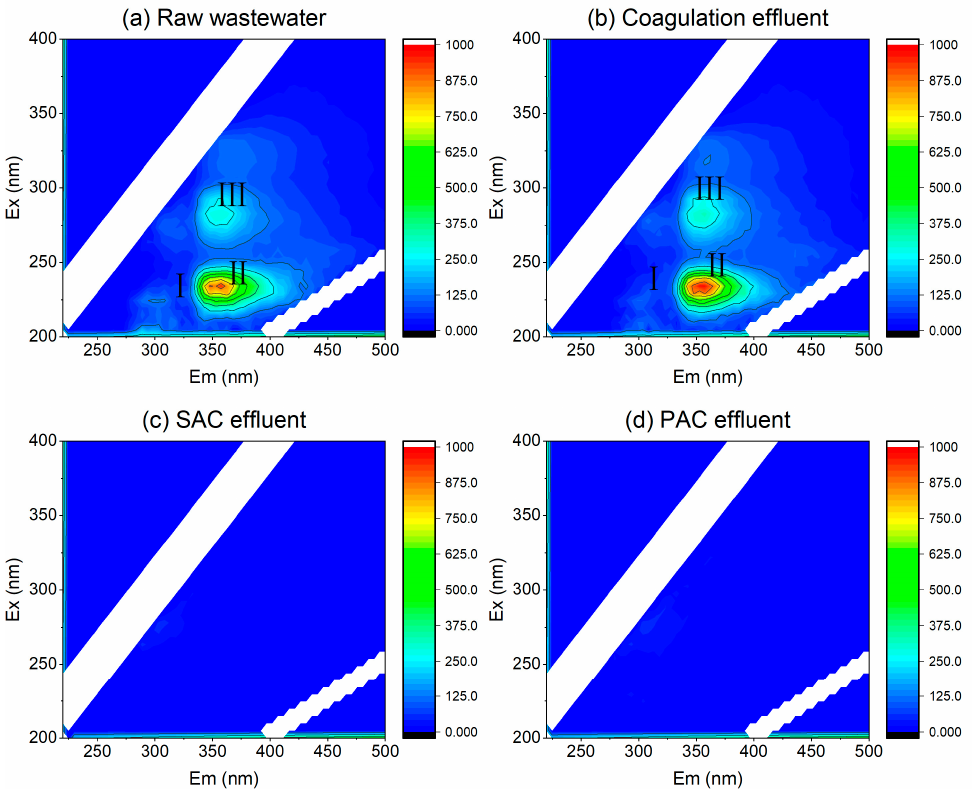
Figure 5. ( a – d ) EEM spectra of ( a ) raw wastewater, ( b ) coagulation effluent, ( c ) SAC adsorption effluent, and ( d ) PAC adsorption effluent.